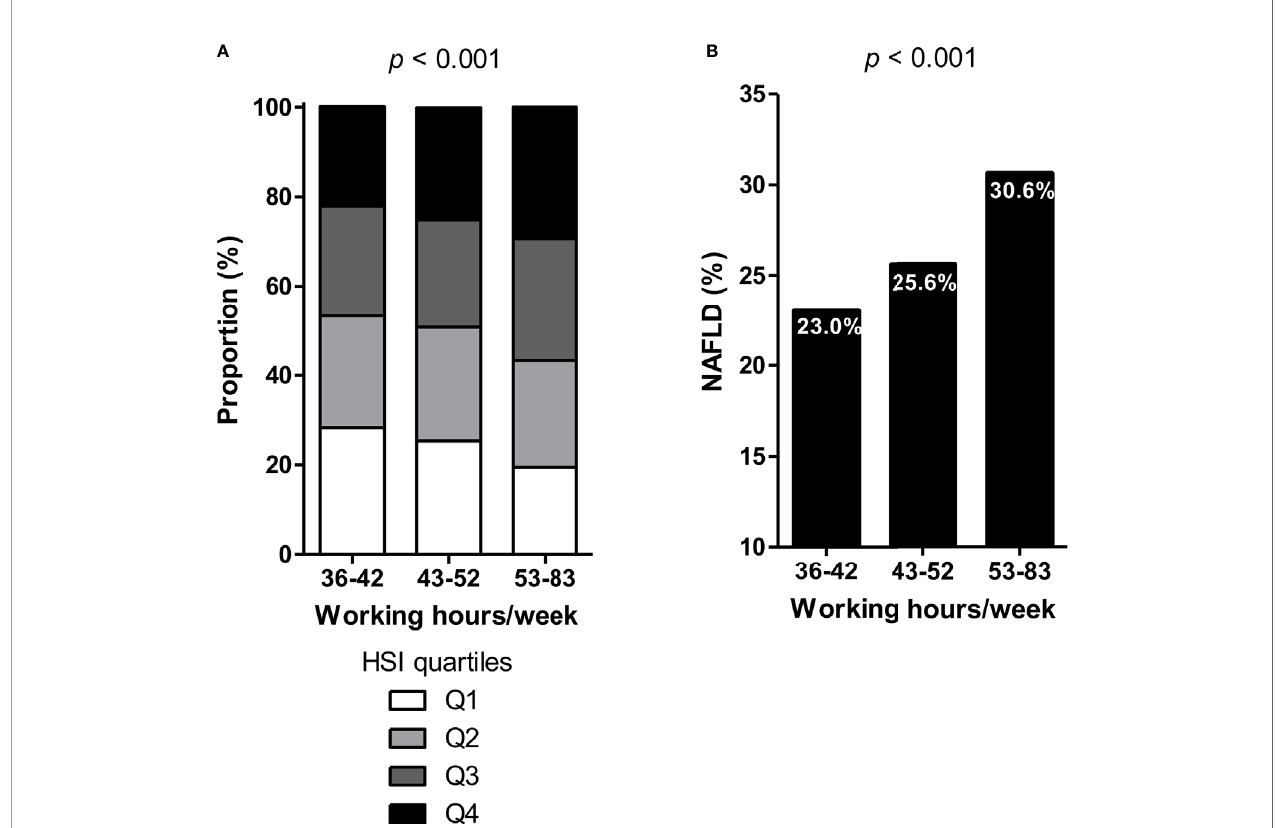
FIGURE 1 | (A) Hepatic steatosis index (HSI) by quartiles and (B) prevalence of NAFLD according to working hours.